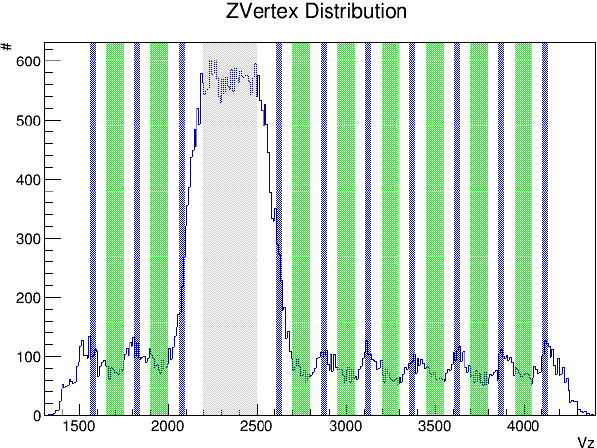
Figure 3. The distribution of the reconstructed vertexes along Z. The structure detector is